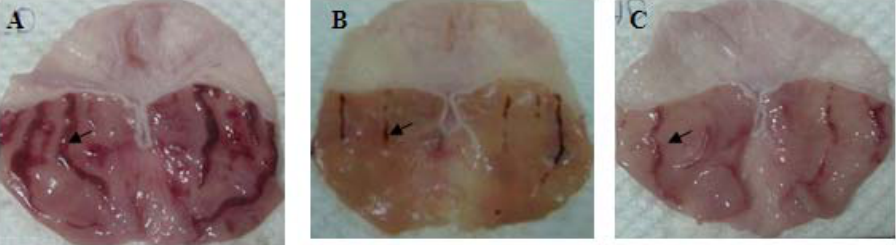
Figure 2. ( A ) Macroscopic evaluation of the gastric mucosa of rats pre-treated with CMC (carboxymethyl cellulose, ulcer control group); ( B ) Omeprazole, 20 mg/kg (positive control group); ( C ) F1 100 mg/kg; ( D ) F2 100 mg/kg; ( E ) F3 100 mg/kg; ( F ) F4 100 mg/kg; ( G ) F5 100 mg/kg (magnification: 1.8×). The black arrows indicate gastric